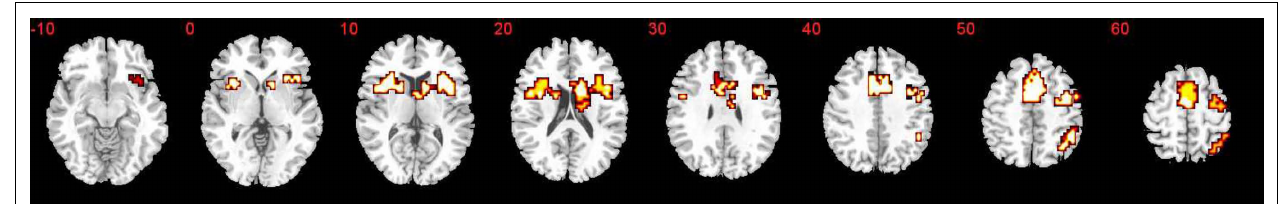
FIGURE 2 | Brain activation during contrast of time discrimination versus temporal order for all subjects. Statistical threshold selected to elicit less than on error cluster ( p < 0.05 for voxel and p < 0.03 for cluster-wise analysis). Slices are marked with the z coordinate as distance in millimeters from the anterior–posterior commissure.